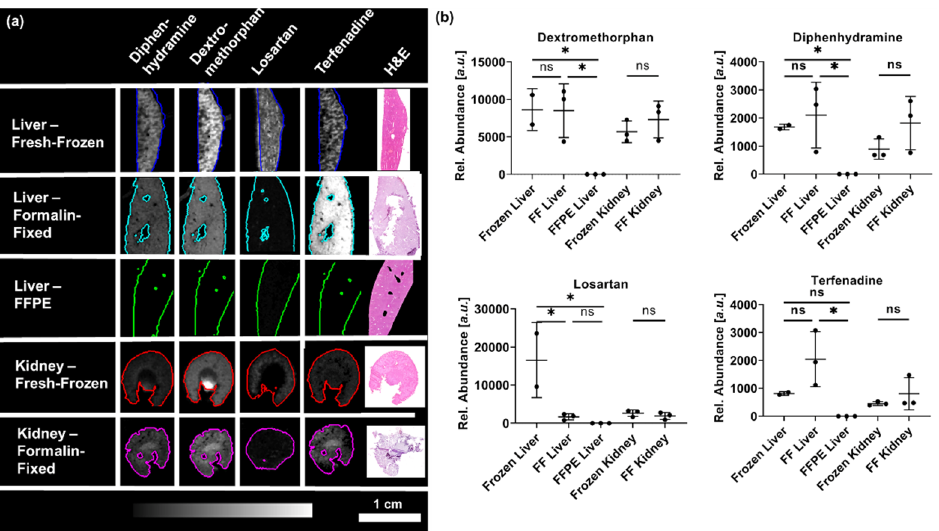
Figure 4. Effects of the sample collection and preparation on ( a ) representative distributions of the drugs and ( b ) mean abundance within the tissue sections for all biological replicates as determined by DESI-MSI. Statistical significance one-way ANOVA for liver samples, two-tailed t -test for kidneys. ns = p (>0.05), * = p (<0.05).